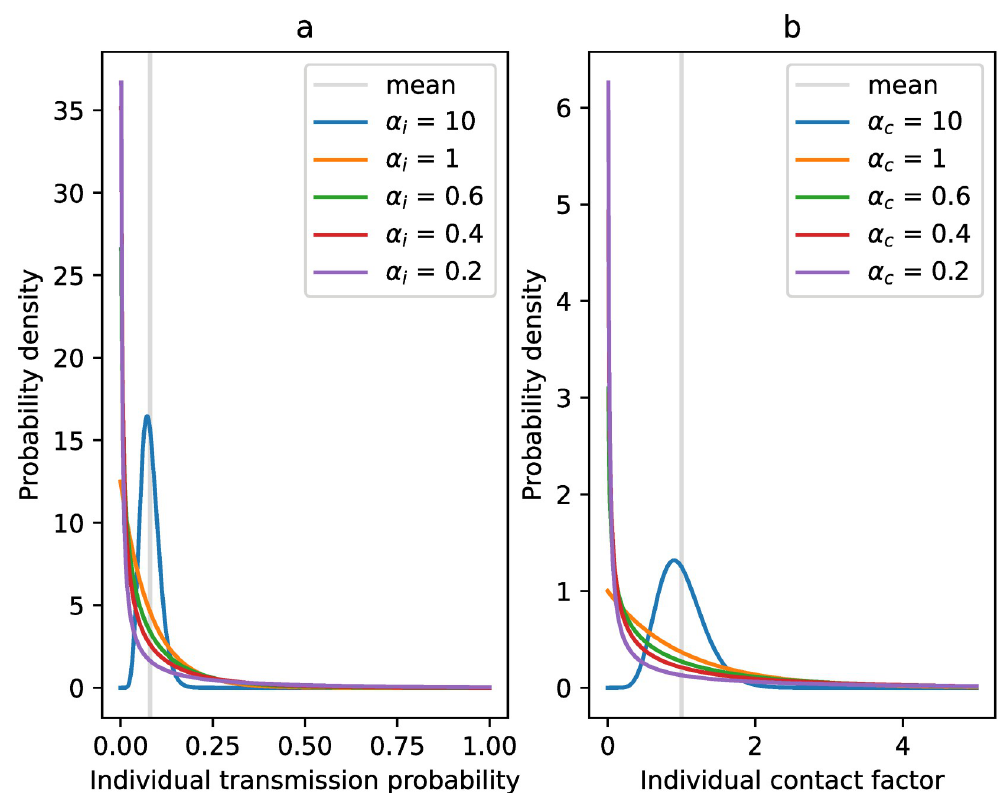
Fig 1. Probability density functions of the Gamma distributions considered for the individual transmission probability (panel a) and the individual contact factor (panel b).